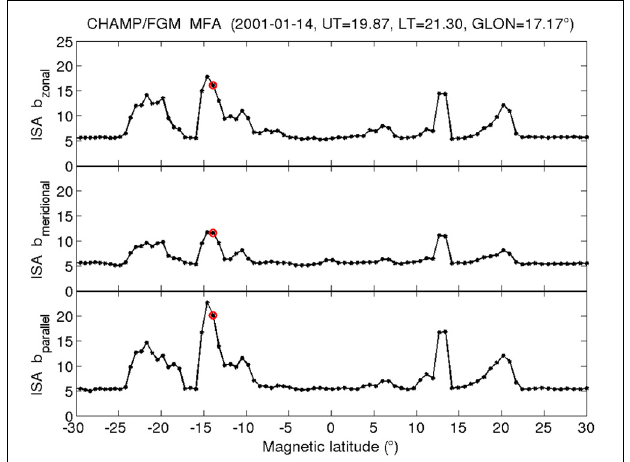
FIGURE 2 | Latitudinal variation of integrated spectral amplitude (ISA) of the three components. The wave activity of the two transverse components is well correlated with the variations of the parallel component.